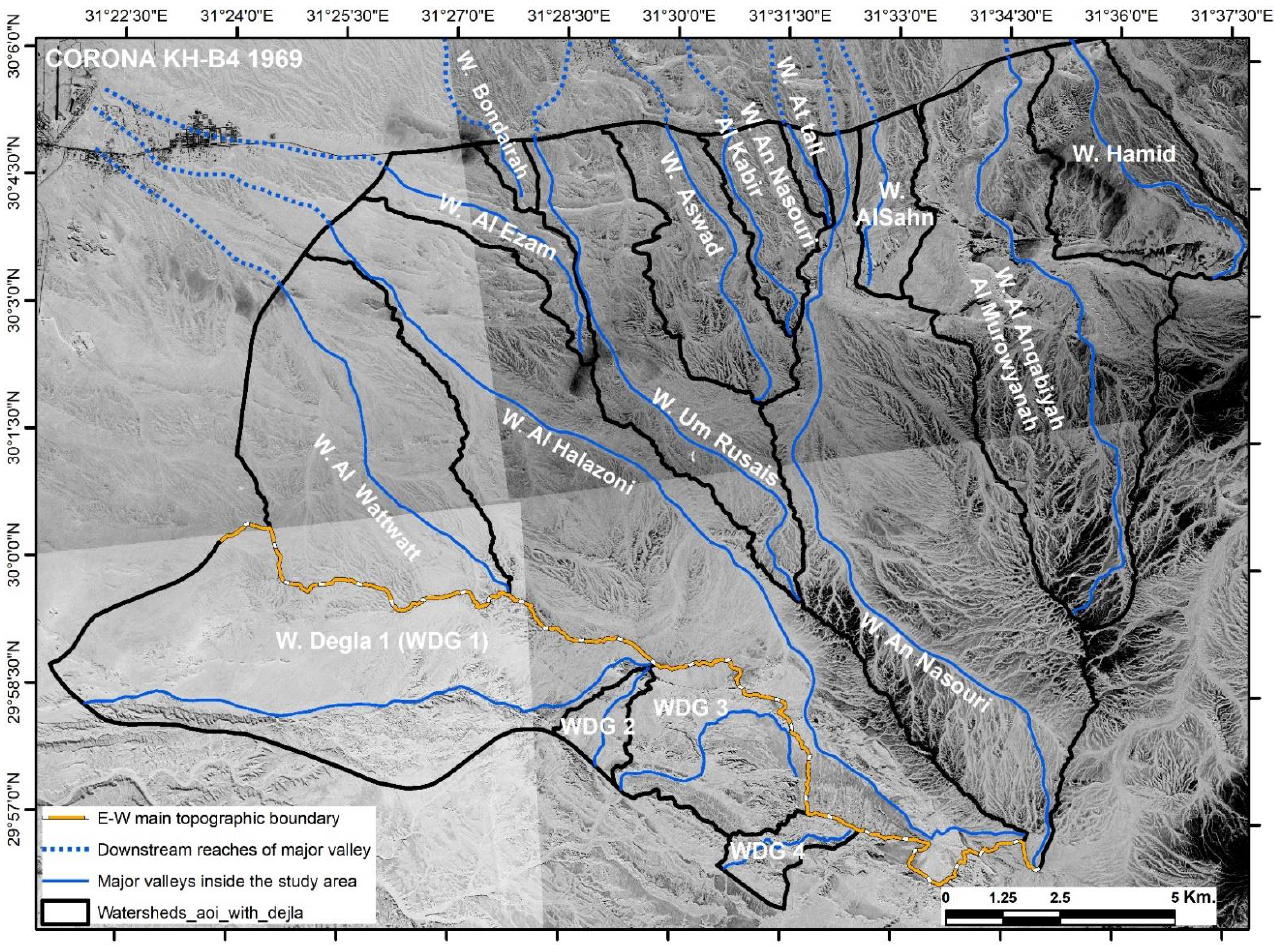
Figure 6. The upstream reaches of NNW and NW watersheds and the northern upstream reaches of W. Degla watersheds. W. Degla